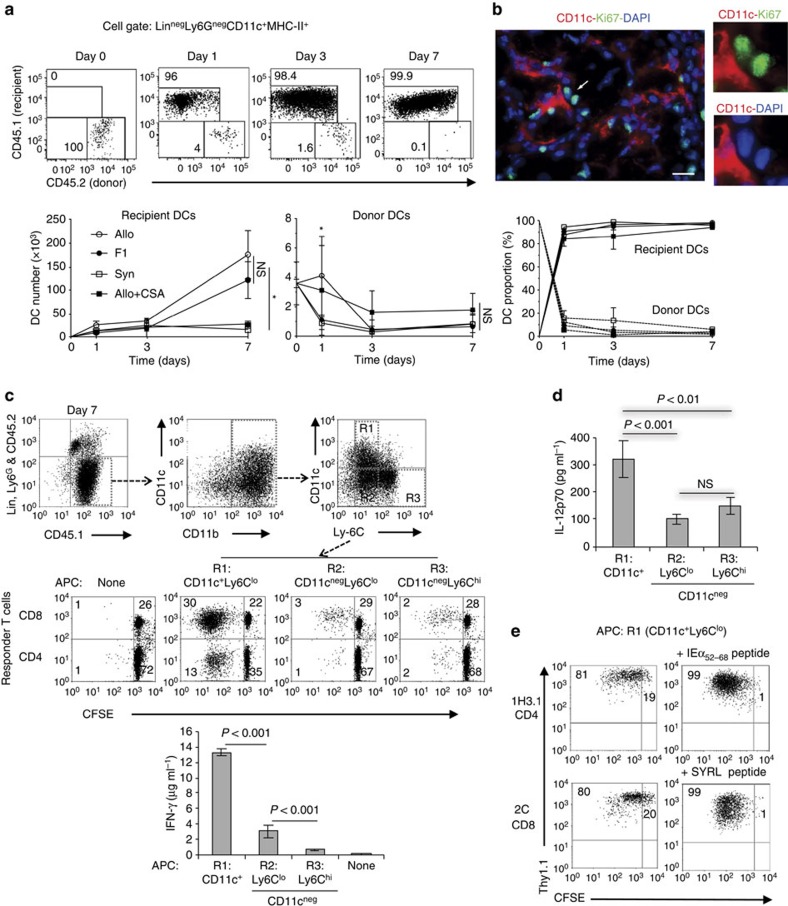
Replacement of donor DCs by host DCs in heart grafts.(a) CD45.2 BALB/c (Allo), (B6 x BALB/c) F1 (F1) or B6 (Syn) heart grafts were transplanted to CD45.1 B6 mice. Intragraft recipient (CD45.1) and donor (CD45.2) DCs were analysed by flow cytometry at indicated time points (day 0, day 1, day 3 and day 7). Representative flow plots and line graphs are shown (mean±s.d., 3 or 4 mice per time point). Full gating shown in Supplementary Fig. 1. CSA, Cyclosporine A. NS, not significant. *P<0.01 (one-way analysis of variance (ANOVA)). In the case of donor DC enumeration significant change was detected in DC number over time but not between groups. (b) Representative photomicrograph of a tissue section of one of 3 BALB/c heart allografts harvested on day 7 and stained for CD11c (red) and proliferation marker Ki67 (green). Cell nuclei are stained with DAPI (blue). The CD11c+ DCs (in red) were Ki67neg. The arrow indicates Ki67 expression, as an endogenous control of Ki67 labelling, in the nuclei of CD11cneg cells shown in detail in the insets. Magnification × 200. Scale bar, 15 μm. (c) Characterization of LinnegLy6Gneg, recipient (CD45.1+) myeloid cells in BALB/c heart allografts on day 7 after transplantation. Cells were analysed by flow cytometry (top panels) and CD11c+ and CD11cneg subsets were sorted and tested for their ability to induce proliferation (centre panels) and IFN-γ production (bar graph) in naive, allogeneic T cells in the direct MLC. Proliferation was measured by CFSE dilution and IFN-γ by ELISA of culture supernatants on day 5 of MLC. One representative experiment out of two is shown. P values were generated by one-way analysis of variance (ANOVA). Bar graphs are mean±s.d. (3 mice per group). (d) IL-12p70 production by sorted CD11c+ and CD11cneg subsets cultured for 24 h. Cells sorted from 2 different BALB/c heart allografts on day 7 were pooled and ELISA was performed in duplicates on the culture supernatant. The experiment was performed twice (4 mice total). Bar graphs are mean±s.d. of 4 measurements (2 experimental × 2 technical replicates). P values were generated by one-way ANOVA. (e) Ability of sorted CD11c+ subset to stimulate proliferation of CD4+ 1H3.1 and CD8+ 2C T cells ex vivo in the absence (left panels) or presence (right panels) of cognate peptide added to the culture (3 mice per group).